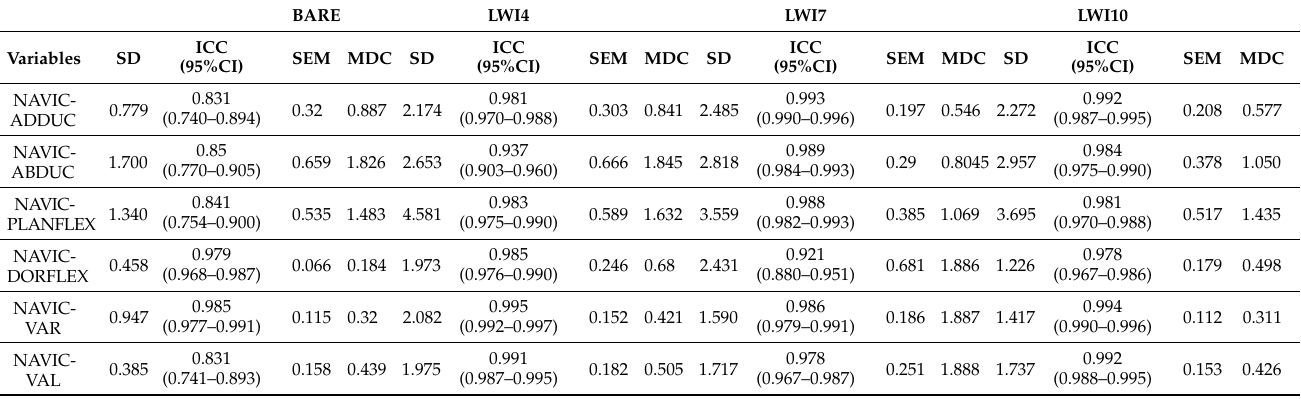
Table 3. The reliability of data for ICC, SEM, and MDC of the navicular bone in barefoot condition and wearing lateral wedge insoles.